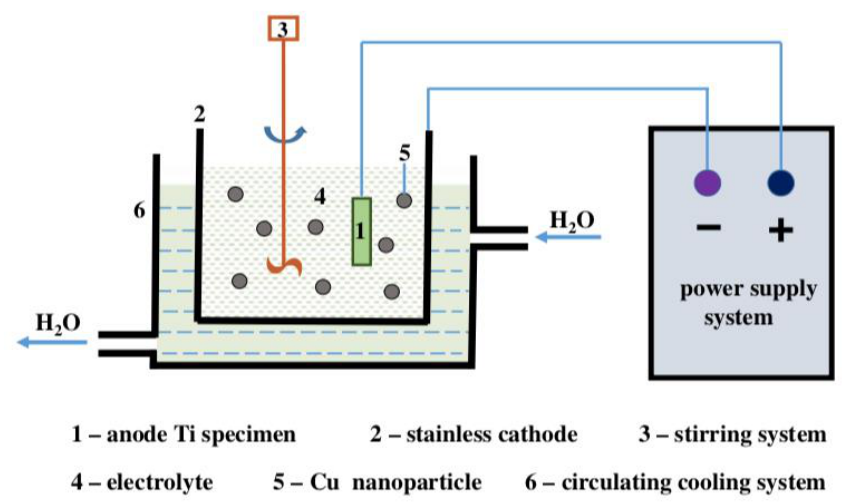
Figure 6. Schematic diagram of the MAO experimental device. Reproduced with permission from Ref. [34]. Copyright 2018, Elsevier.